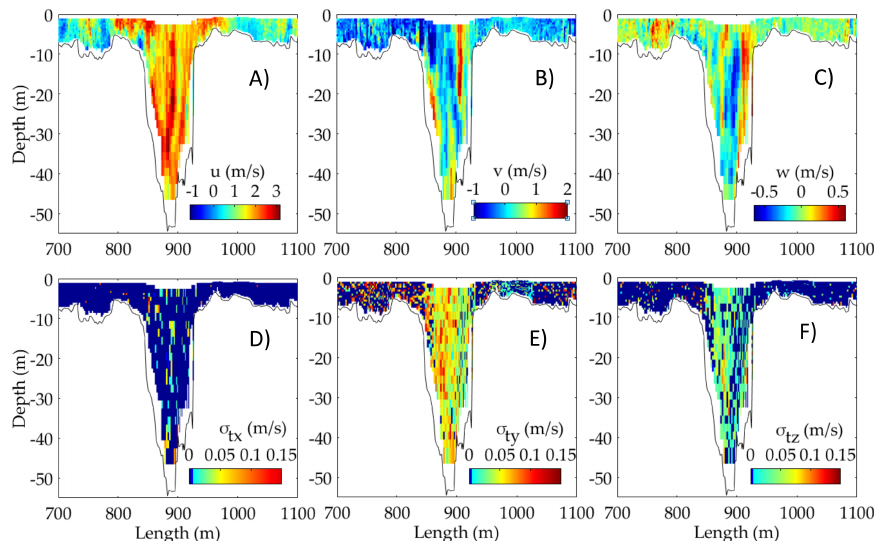
Figure 6. Flow velocity profiles over the canyon part (April 2015); ( A – C ) Magnitude of mean velocity components <u> (longitudinal), <v> (transversal), <w> (vertical) over cross-section; ( D – F ) Magnitude of turbulent velocity fluctuations.